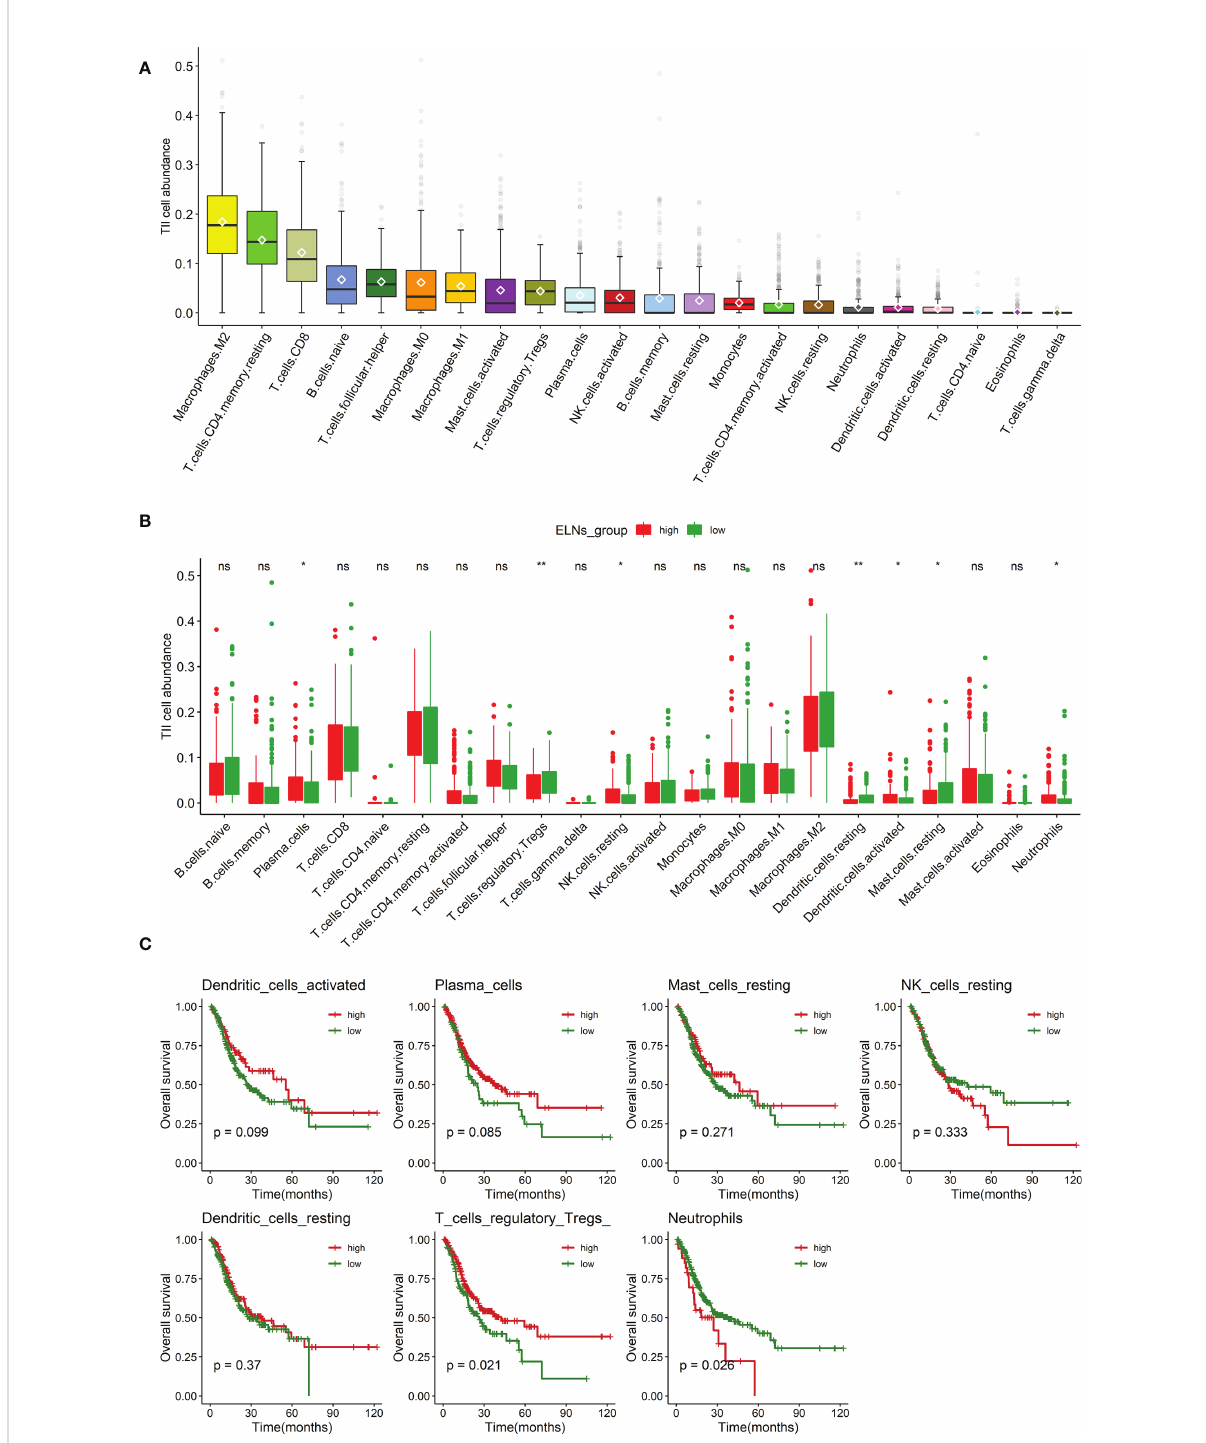
FIGURE 9 Analysis of the ELNs-related TIICs. (A) Distribution of 22 types of TIICs in gastric cancer. (B) Box plot displays the abundance differentiation of 22 types of immune cells between the GC samples with low- and high-ELN groups, and the signi fi cance test was carried out by the Wilcoxon rank- sum test. (C) Kaplan – Meier and log-rank test for seven immune cells passed the Wilcoxon rank-sum test. Four representative immune cells including plasma cells, neutrophils, and regulatory T cells (Tregs) are shown based on their respective optimal cutoff values (all p < 0.1). ELNs, the number of lymph nodes examined; TIICs, tumor-in fi ltrating immune cells; GC, gastric cancer. *p < 0.05; **p < 0.01.ns, no signi fi